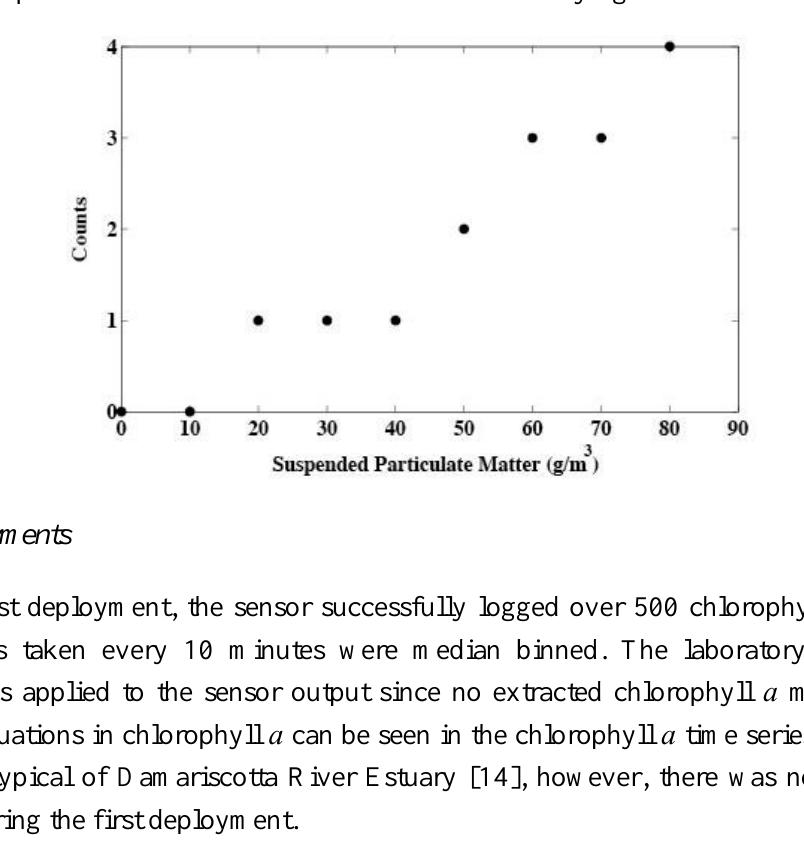
Figure 6. Sensor response to water turbidity. The figure shows counts returned by the sensor when placed in a mixture of deionized water and varying amounts of bentonite